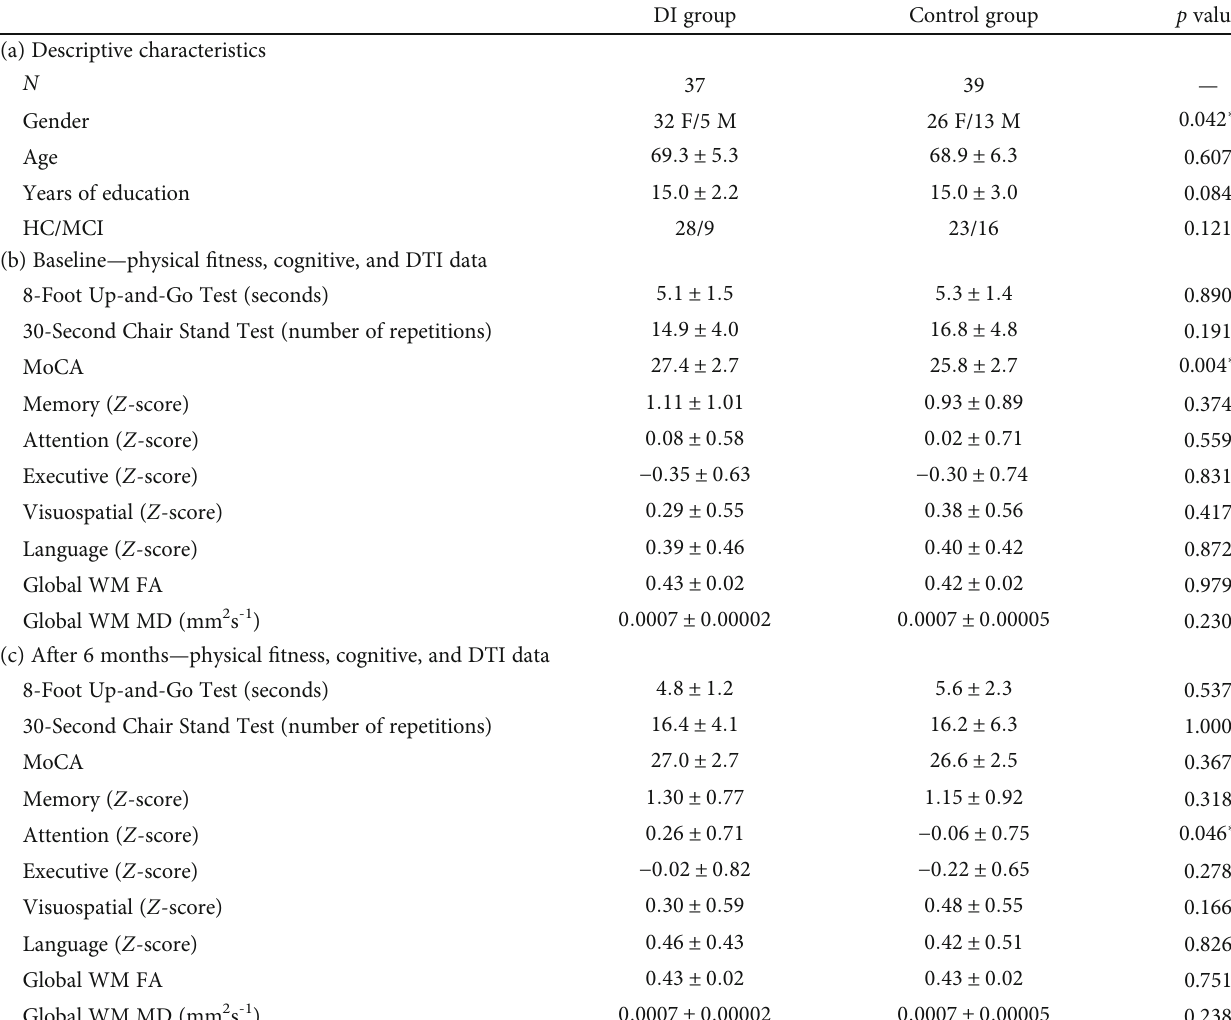
Table 1: (a) Descriptive characteristics. (b) Physical fi tness, cognitive, and DTI data at the baseline. (c) Physical fi tness, cognitive, and DTI data after 6 months. Mean ± standard deviation . ∗ Signi fi cant di ff erence.